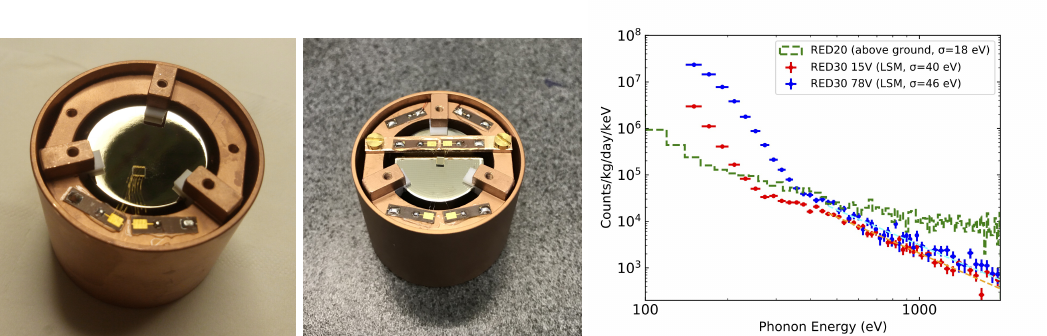
Figure 3: Left and center panels: picture of the 33.4 g EDELWEISS detectors RED20 and RED30, respectively, in their copper holder. The exposed side shows the Ge- NTD thermistances glued on the top side. Right : Efficiency-corrected event rates, in events per kgd and per keV, as a function of the total phonon energy in eV. Green dashed: RED20. Red and blue points: spectra recorded by RED30 with biases of 15 and 78 Volt, respectively. The rises below 300 eV correspond to the onset of the read-out noise. The lines are fits to guide the